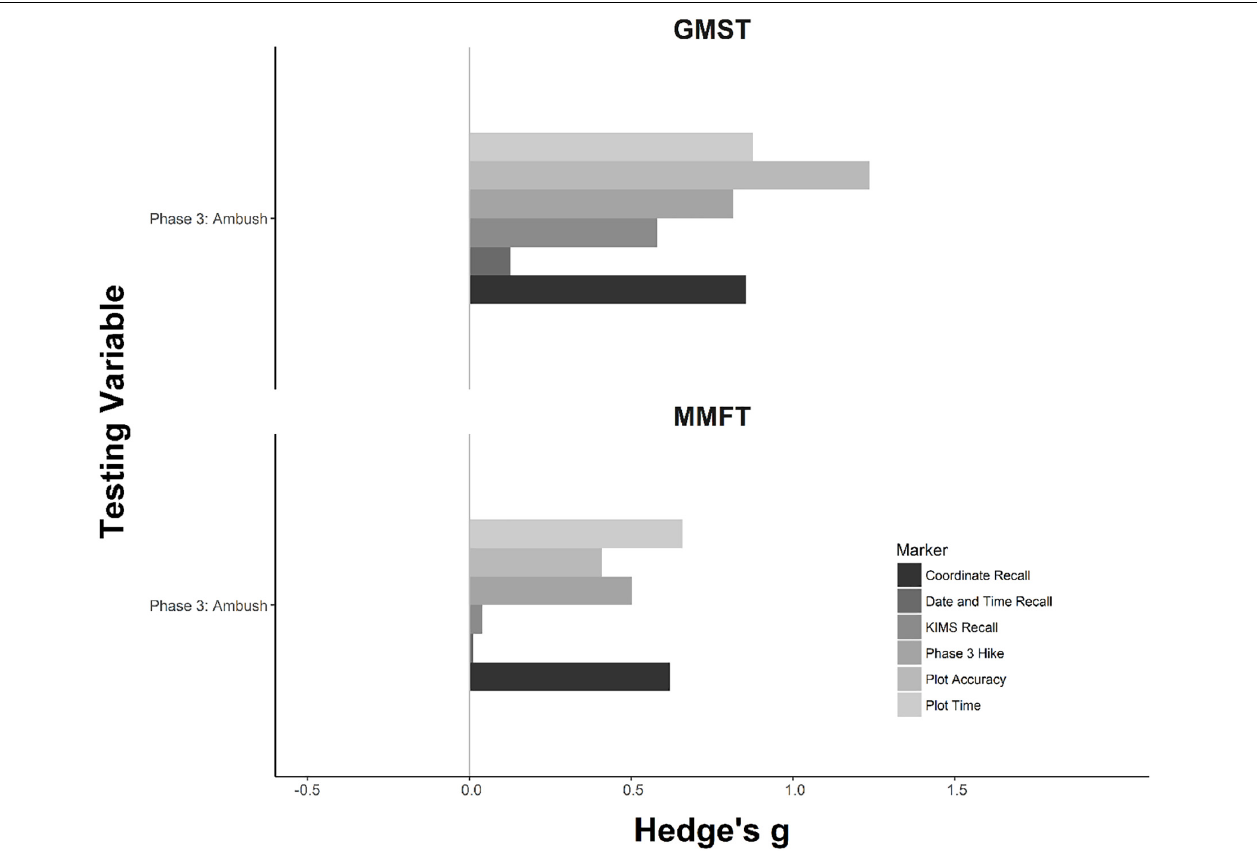
FIGURE 2 | Effect size comparisons of group differences between GMST, MMFT, and TAU during the highly stressful Ambush training phase. The horizontal axis represents the Hedge’s g for each observation. The vertical axis represents the measured metric. Zero indicates no difference between the MST group and TAU. Larger positive effect sizes, indicated by a bar to the right beyond 0, indicate desired differences for MMFT and GMST when compared to TAU. Negative effect sizes, indicated by a bar to the left beyond 0, indicate an undesired effect when compared to